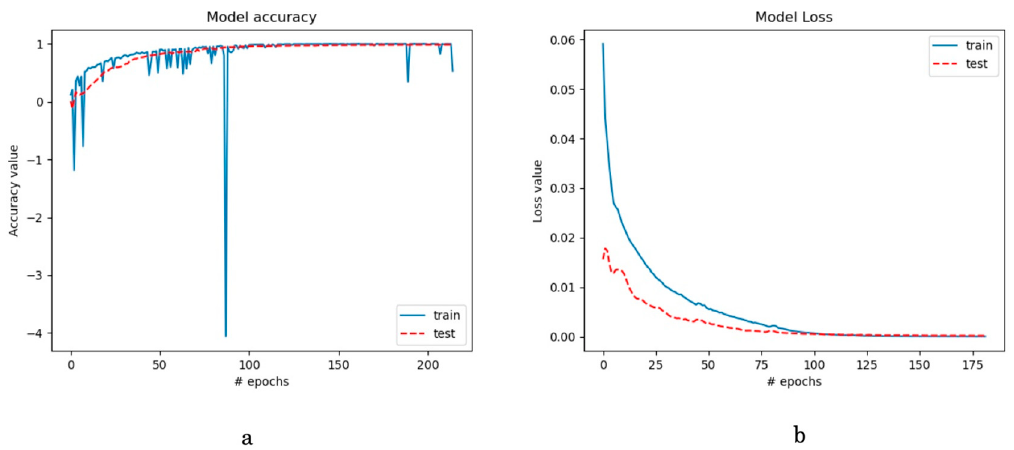
Figure 10. ANN regression plots for the experimental data. ( a ) Model Accuracy ( b ) Model Loss